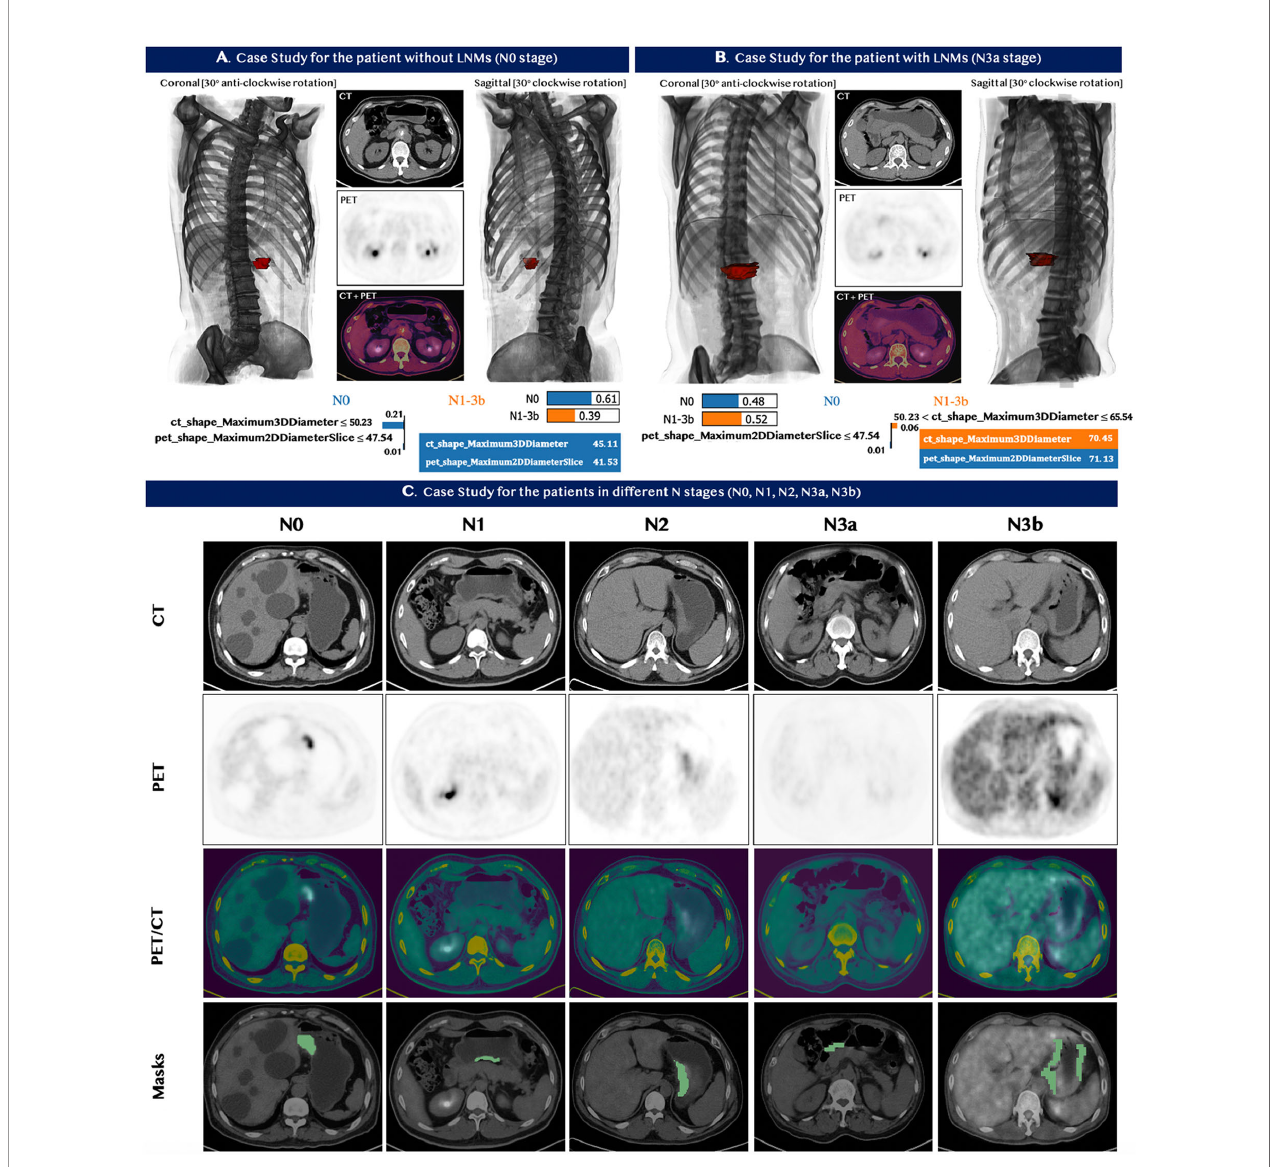
FIGURE 5 | Case studies for seven patients with GC. Top Panels: (A) patient with no lymph nodes metastases. (B) patient with lymph nodes metastases. The image at the bottom of (A, B) contains the feature value of the patients and the corresponding LIME interpretation. The top left and top right sections in panel (A, B) demonstrated the 3D model constructed based on the input CT and PET images from different viewpoints, while the red section represented the tumor of the patients. Our predictive model correctly identi fi ed the status for both patients in panel (A, B) . (C) Bottom Panel - Five patients with different stages N0, N1, N2, N3a, and N3b from left to right. Our machine learning model predicted the N stage of the fi ve patients accurately. 18 F-FDG PET/CT, however, did not detect LNMs in all fi ve patients; and CECT also did not assess the N stages